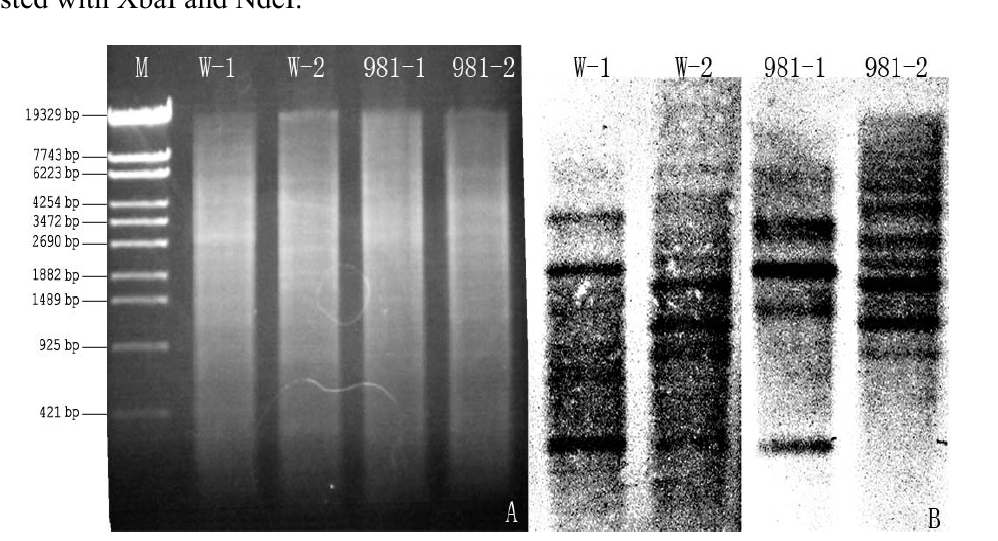
Figure 4. Genomic DNA digested with endonucleases and Southern blotting of Mn-SOD both in W and 981. W-1 and 981-1 were digested with SacI and KpnI, W-2 and 981-2 were digested with XbaI and